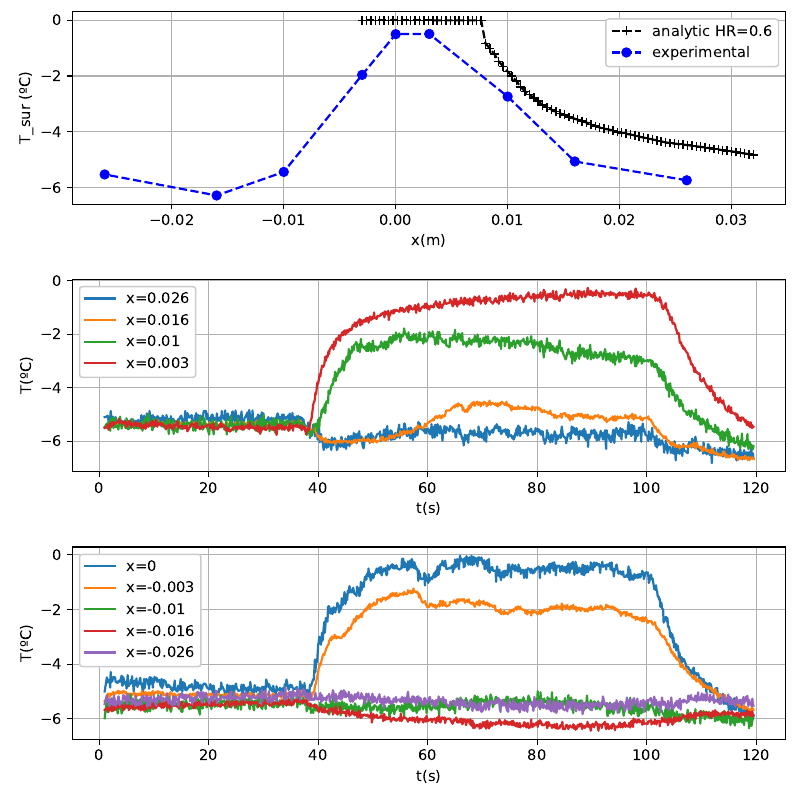
Figure 11. Test conditions: angle of attack: − 5 ◦ . V = 70 m/s. LWC = 0.95 g/m 3 . MVD = 20 µ